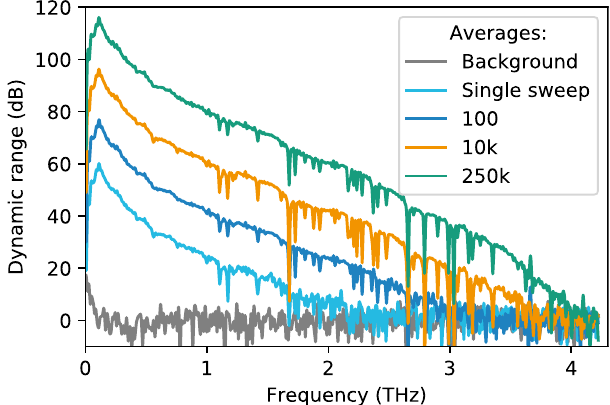
Fig. 4 Terahertz spectra recorded with the optoelectronic FMCW THz spectrometer. Spectral sweeps were captured at a repetition rate of 68 Hz and at frequency steps of 1 GHz. The plot shows the amplitude dynamic range for different numbers of averaged spectra, which are normalized to their respective noise level (indicated by gray line). The dips in the spectrum are absorption lines of the atmospheric water